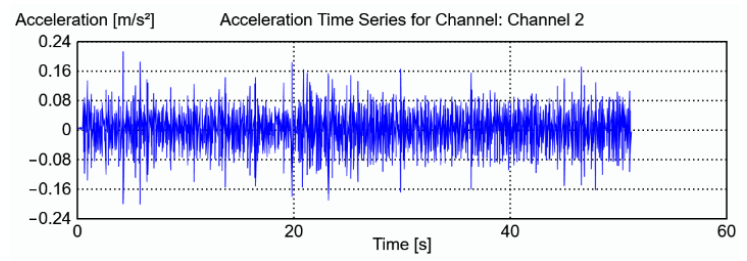
Figure 3. The record of the raw data in the time domain from one of the sensors.